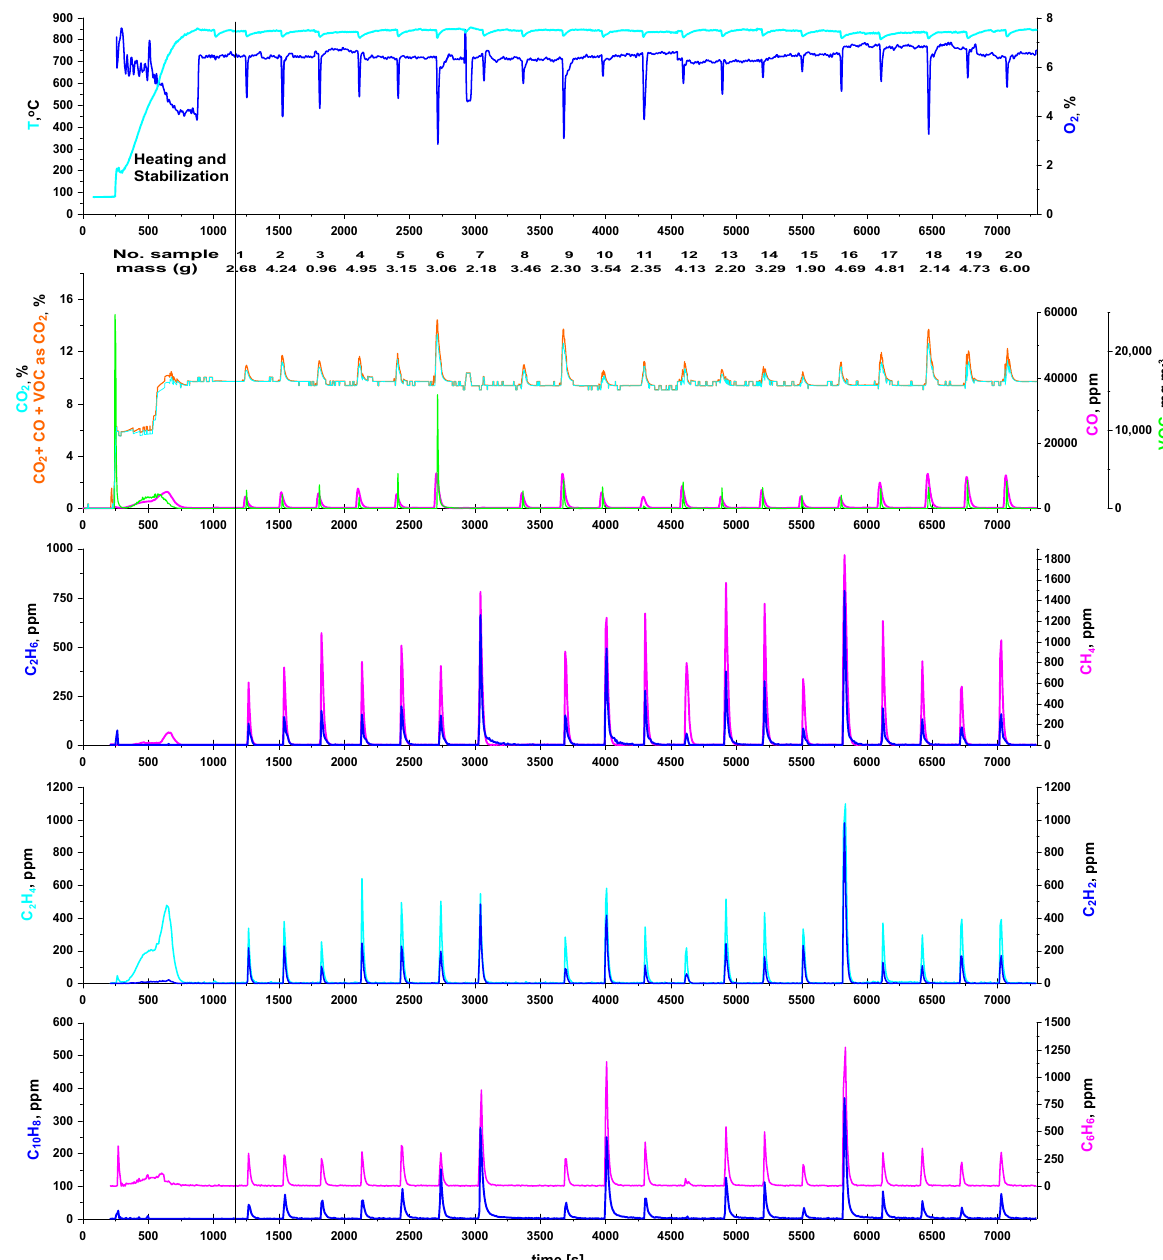
Figure 3. Changes in the concentrations of aliphatic and aromatic hydrocarbons and O 2 , CO, CO 2 , VOCs in the exhaust gases generated during thermal treatment of mobile phone waste in a fluidised bed.